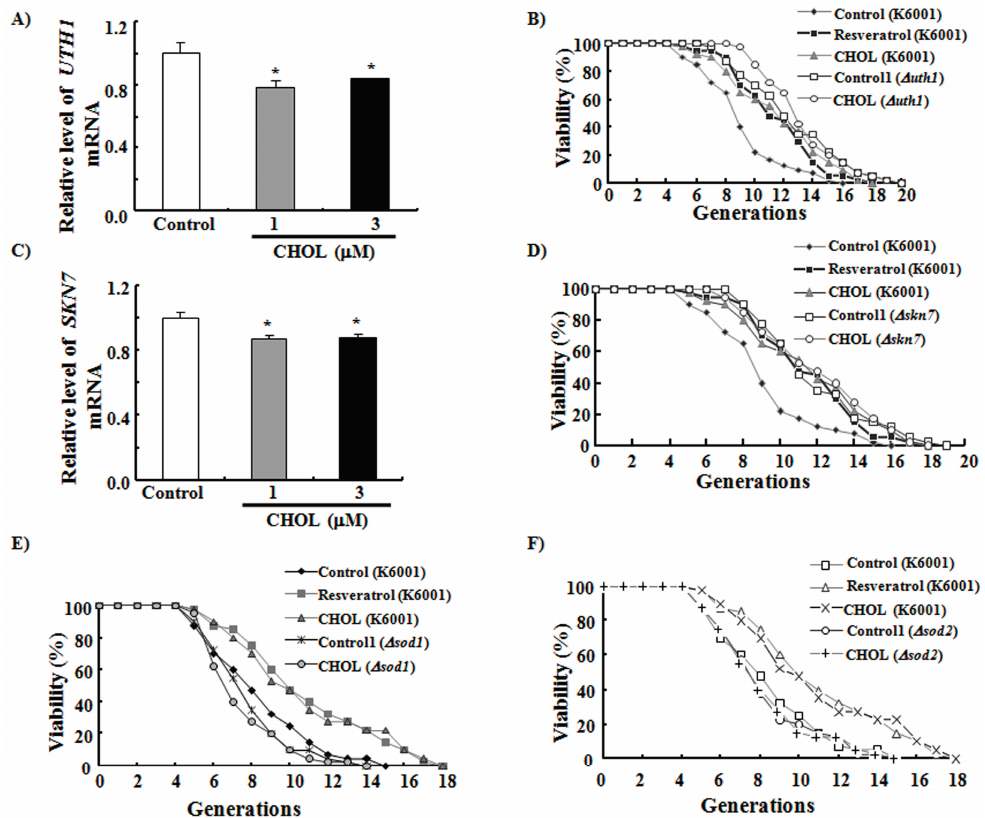
Figure 4. Effects of CHOL on UTH1 and SKN7 genes expression and the replicative lifespans of uth1 , skn7 , sod1 , and sod2 mutations. ( A ) Effects of CHOL on UTH1 gene expression. The relative level of UTH1 mRNA in control group is 1.01 ± 0.06; CHOL at 1 μ M, 0.79 ± 0.04 * ; CHOL at 3 μ M, 0.84 ± 0.01 * ; ( B ) Effect of CHOL on uth1 mutation with a K6001 background. The average lifespan of the K6001 control group was 8.3 ± 0.44 generations; resveratrol at 10 μ M, 10.7 ± 0.49 *** ; CHOL at 1 µM, 10.7 ± 0.55 *** . The average lifespan of the uth1 mutation control1 group was 11.7 ± 0.53 generations; CHOL at 1 µM, 12.4 ± 0.42; ( C ) Effects of CHOL on SKN7 gene expression. The relative level of SKN7 mRNA in control group is 1.00 ± 0.03; CHOL at 1 μ M, 0.87 ± 0.02 * ; CHOL at 3 μ M, 0.88 ± 0.03 * ; ( D ) Effect of CHOL on skn7 mutation with a K6001 background. The average lifespan of the K6001 control group was 8.3 ± 0.44 generations; resveratrol at 10 μ M, 10.7 ± 0.49 *** ; CHOL at 1 µM, 10.7 ± 0.55 *** . The average lifespan of the skn7 mutation control1 group was 11.0 ± 0.47 generations; CHOL at 1 µM, 11.2 ± 0.50; ( E ) Effect of CHOL on sod1 mutation with a K6001 background. The average lifespan of the K6001 control group was 7.6 ± 0.43 generations; resveratrol at 10 μ M, 10.0 ± 0.57 *** ; CHOL at 1 µM, 9.9 ± 0.60 ** . The average lifespan of the sod1 mutation control1 group was 7.0 ± 0.35 generations; CHOL at 1 µM, 6.7 ± 0.35; ( F ) Effect of CHOL on sod2 mutation with a K6001 background. The average lifespan of the K6001 control group was 7.6 ± 0.43 generations; resveratrol at 10 μ M, 10.0 ± 0.57 *** ; CHOL at 1 µM, 9.9 ± 0.60 ** . The average lifespan of the sod2 mutation control1 group was 7.3 ± 0.41 generations; CHOL at 1 µM, 7.3 ± 0.41. * p < 0.05, ** p < 0.01 and *** p < 0.001 indicate statistically significant